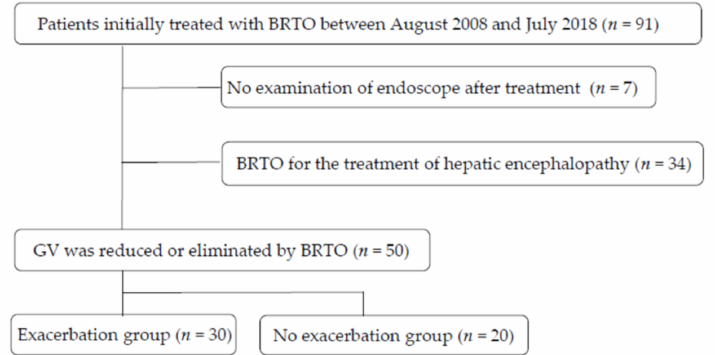
Figure 1. Flowchart showing patients enrolled in this study. BRTO: balloon-occluded retrograde transvenous obliteration; GV: gastric